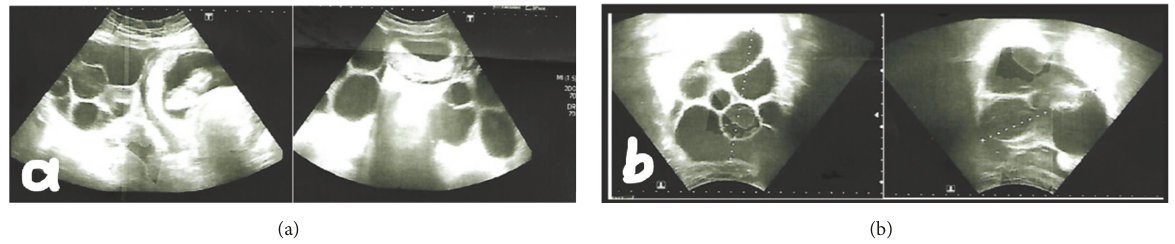
Figure 2: (a) Intrauterine pregnancy with gestational age of 10w and multicystic appearance in left ovary. (b) Bilateral ovaries (left ovary, 12 ∗ 12, 5cm; right ovary, 11 ∗